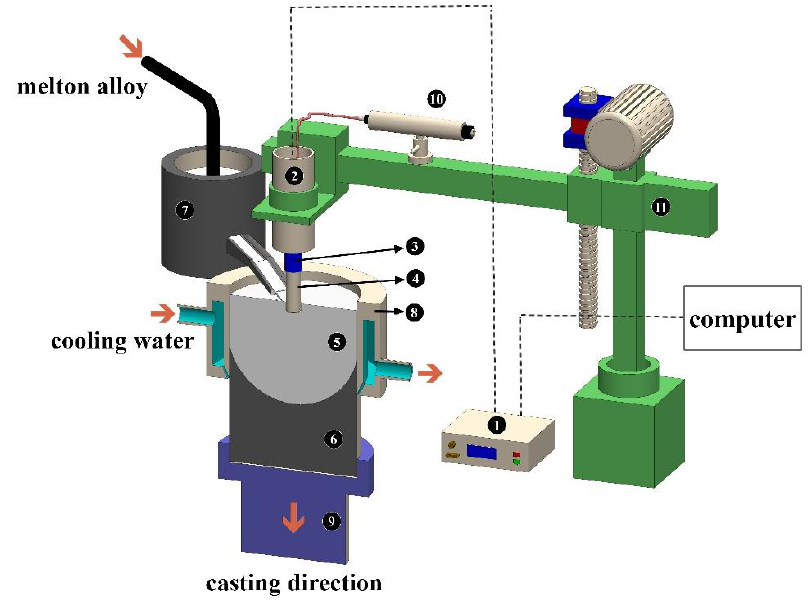
Figure 1. Schematic of the experimental set-up: 1—ultrasonic power supply, 2—ultrasonic converter, 3—acoustical wave-guide, 4—acoustic radiator/horn, 5—liquid melt, 6—billet, 7—tundish, 8 —crystallizer, 9—dummy bar head, 10—air cooler, 11—positioning